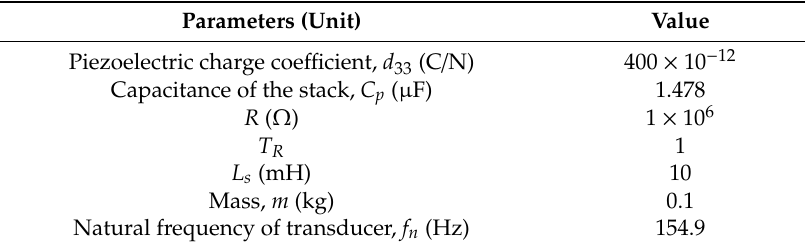
Table 1. Parameters of the piezoelectric stack and the hybrid